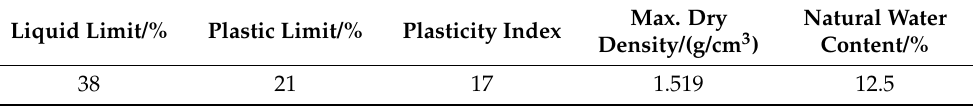
Table 1. Basic parameters of the soil at the Zhouqiao site.